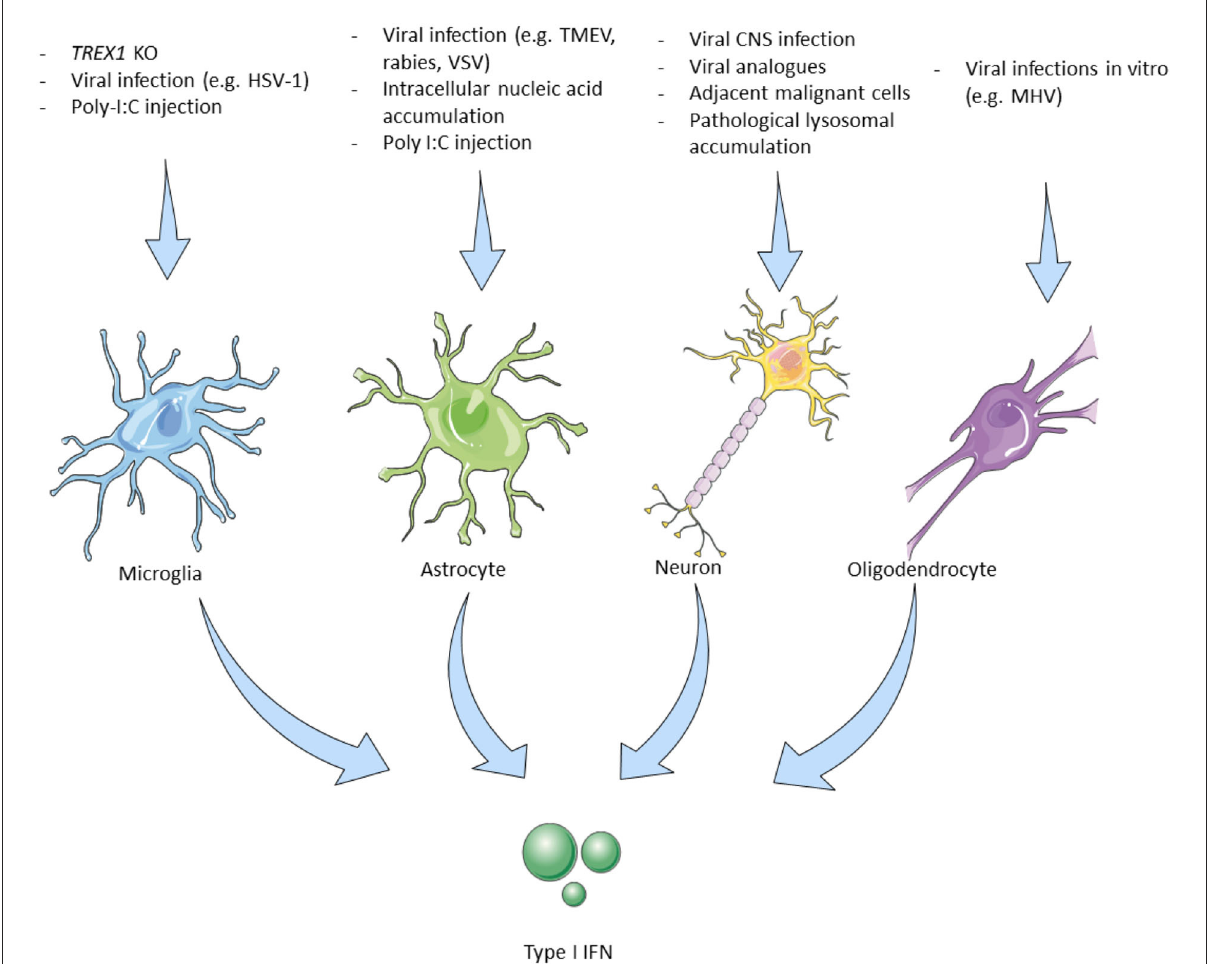
FIGURE1 Triggers leading to type I interferon production by cells of the central nervous system. Microglia, The main type I IFN producer cells in the CNS. Trex1 homozygous deletion selectively in murine microglial cells induced type I IFN production. Intrathecal poly I:C induces IFN- β production in EAE with subsequent therapeutic effects (28). Microglial cells are the main producers of cGAS–STING-dependent type I IFN in animal models of HSV-1 encephalitis (29). Astrocytes, Murine-derived astrocytes can be experimentally triggered by viral and microbial infection analogs to produce type I IFN. IFN- β mainly produced by astrocytes in different CNS viral infections in mouse models (30). Neurons, In vitro murine and human neurons produce IFN- β upon stimulation with viruses or their analogs (31). Viral encephalitis also causes neuronal type I IFN production but only by 3% of the infected murine neurons in vivo . Some neurons adjacent to GBM cells express the IFN- β dependent PD-L1 which improves survival (32). IFN- β -/- neurons have a worse prognosis. Specific cortical neurons in patients with Gaucher disease affecting the CNS show elevated IFN- β production (33). Oligodendrocytes, MHV infection in vitro (mouse-derived cells) induces type I IFN production. MHV infection (JHM strain) in live mice did not lead to IFN-I production (18). IFN, interferon; CNS, central nervous system; Trex1, three prime repair exonuclease 1; EAE, experimental autoimmune encephalomyelitis; HSV, herpes simplex virus; cGAS, cyclic GMP–AMP synthase; STING, stimulator of type I IFN genes; TLR, toll-like receptor; AGS, Aicardi Goutières syndrome; LPS, lipopolysaccharides; TMEV, Theiler’s murine encephalomyelitis